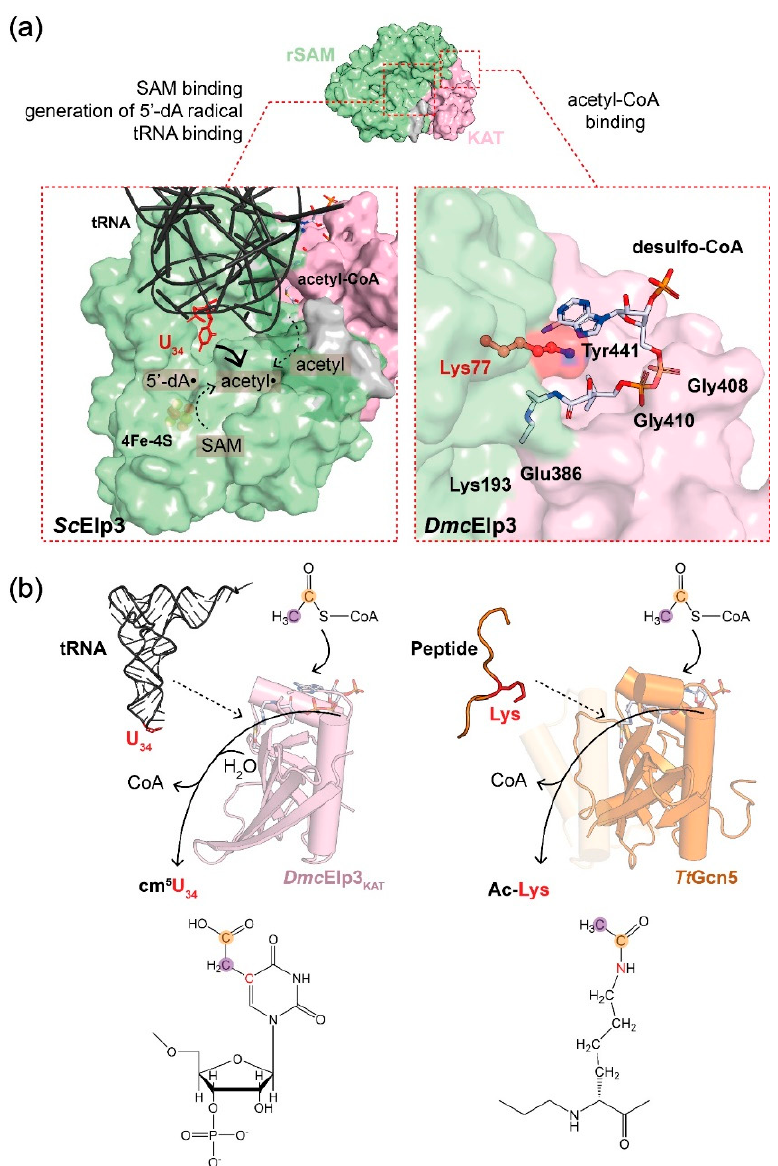
Figure 2. Biochemical features of Elp3. ( a ) Illustrations of the Elp3-dependent cm 5 U modification reaction (left) and the crystal structure of the acetyl-CoA binding pocket of DmcElp3 with desulfo-CoA (right, PDB: 6IA6). The components in the cm 5 U reaction are as indicated. The ligand contacting residues are labeled, while the conserved lysine (Lys77 in DmcElp3) is highlighted in red. ( b ) Schemes of the proposed tRNA-triggered acetyl-CoA hydrolysis of Elp3 (left) and Gcn5-mediated protein acetylation mechanism (right). The modifiable U 34 and reactive K 14 of histone H3 peptide are colored in red. For a clearer presentation, the α 1 and α 2 helices of TtGcn5 are shown in a transparent style. Acetyl-CoA, shown in cartoon, is modeled in the binding pockets of Elp3 or Gcn5, whereas the chemical structure of acetyl-CoA is shown on the top and the reactive carbons are highlighted in an orange circle (acetyl radical for cm 5 modification) or purple circle (carbonyl group of the thioester of acetyl-CoA). The reactive sites of cm 5 U 34 and Ac-Lys are both colored in red and present the C-C bond for the cm 5 addition and the C-N bond for the acetyl-lysine addition,